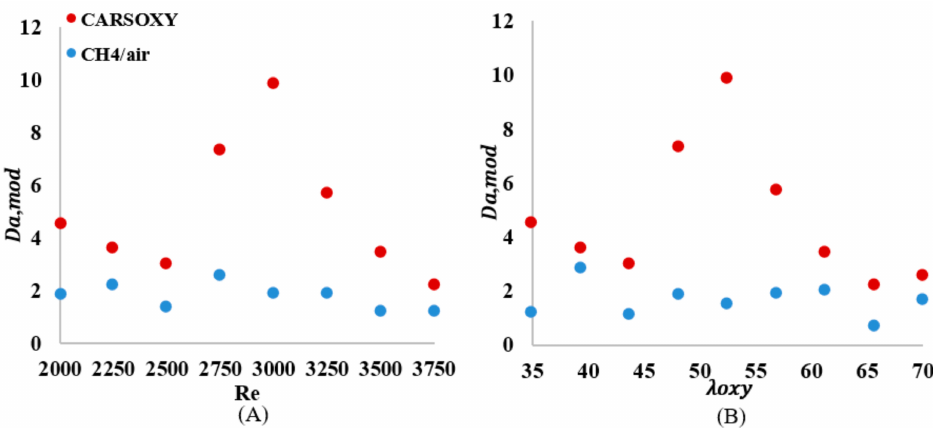
. V CH4 = 1 L/min and